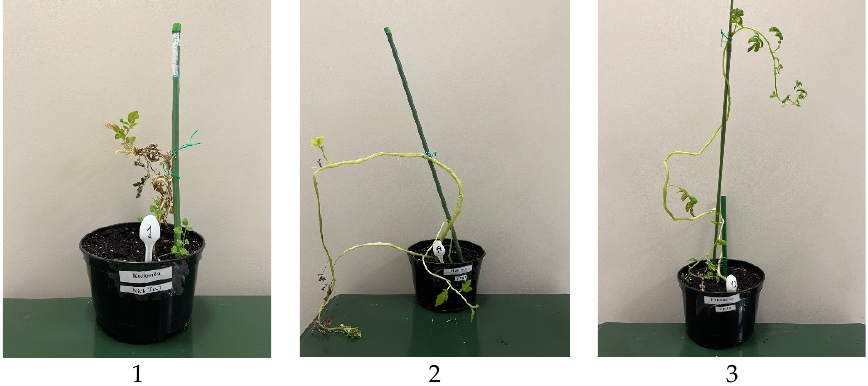
Figure 10. Symptoms of viroid infection at 90 days after planting on cultivars of the second re- production: 1—Colomba, strain NicTr-3, 2—Nevskiy, strain VP87, 3—Elizaveta, strain VP35.